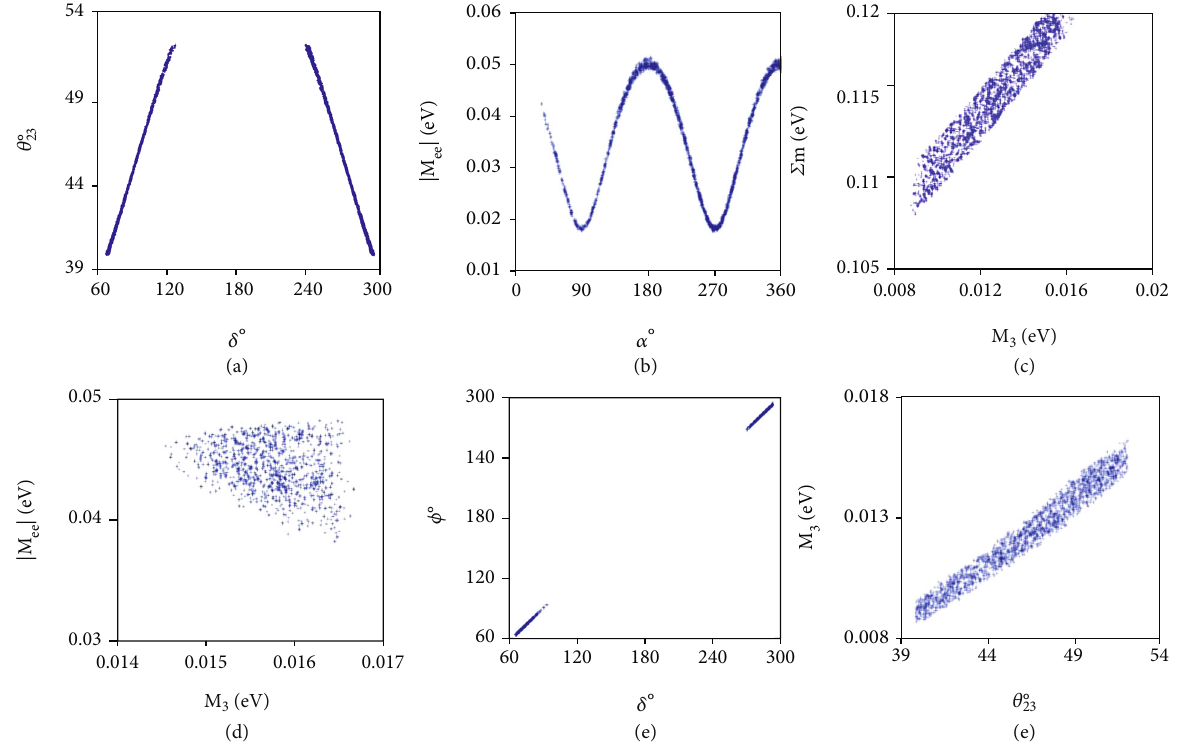
Figure 4: Correlation plots among various parameters for textures (a) M 4